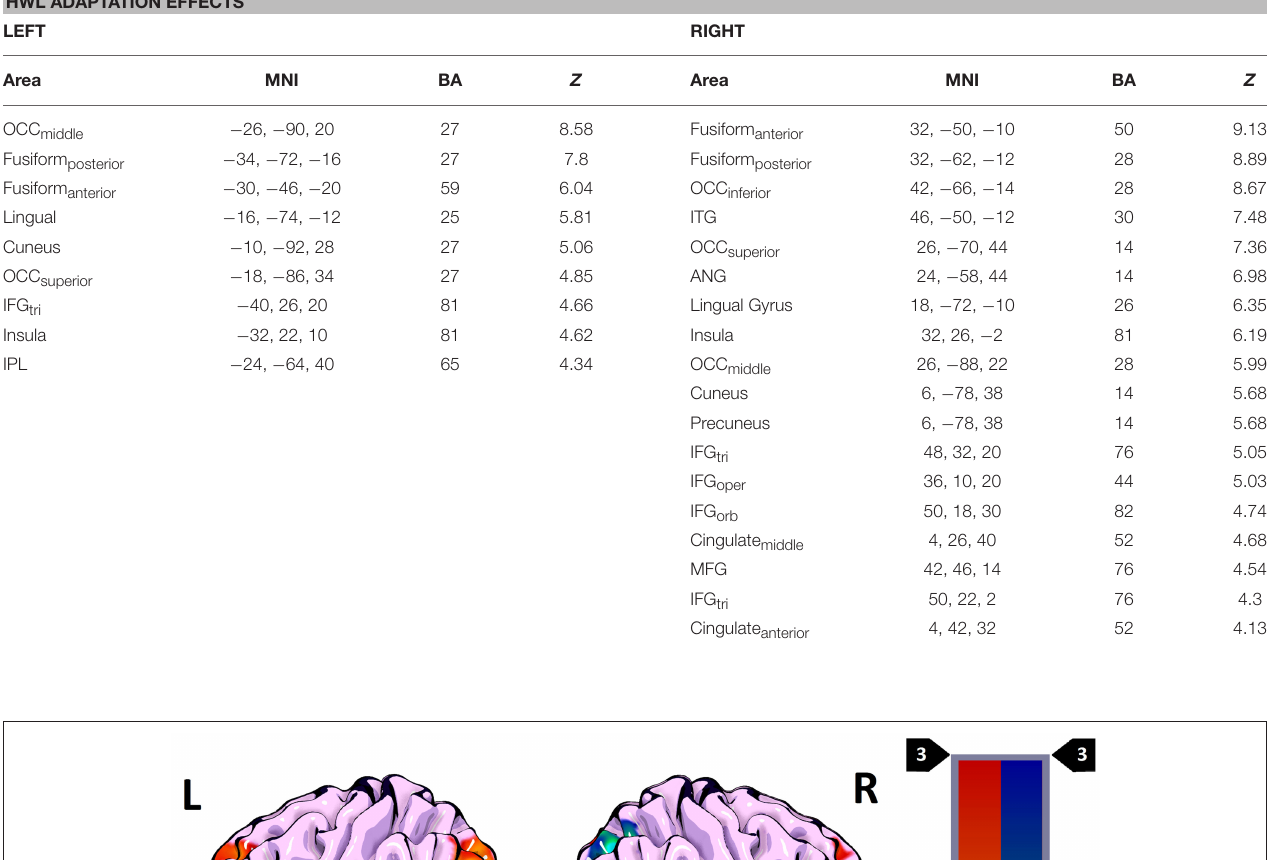
TABLE 3 | Brain areas showing greater activity following sequential presentation of two different health warning labels, as opposed to two identical health warning labels.